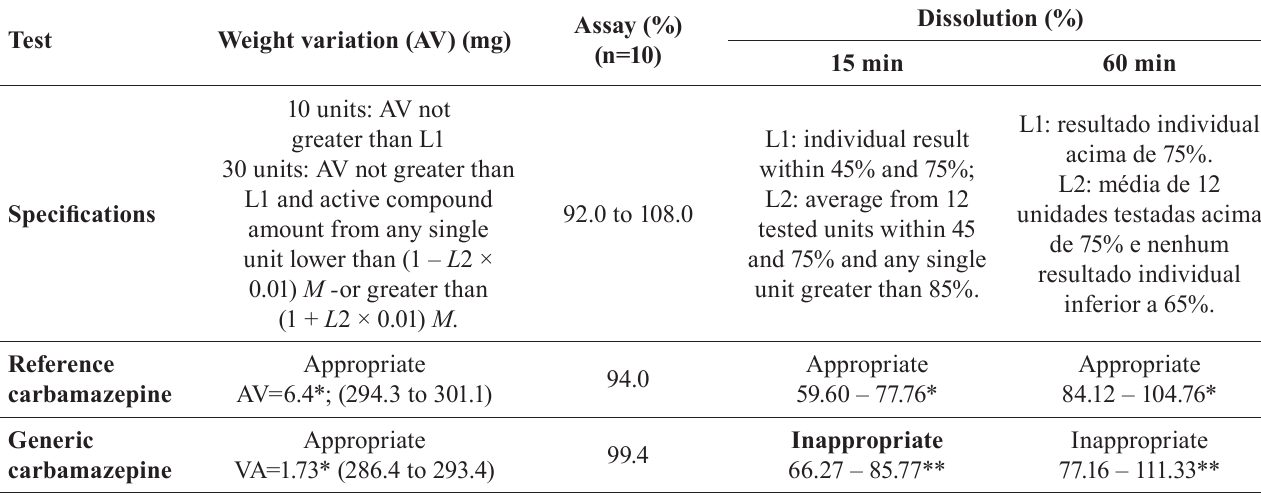
TABLE V - W eight variation, assay and dissolution for generic and reference carbamazepine